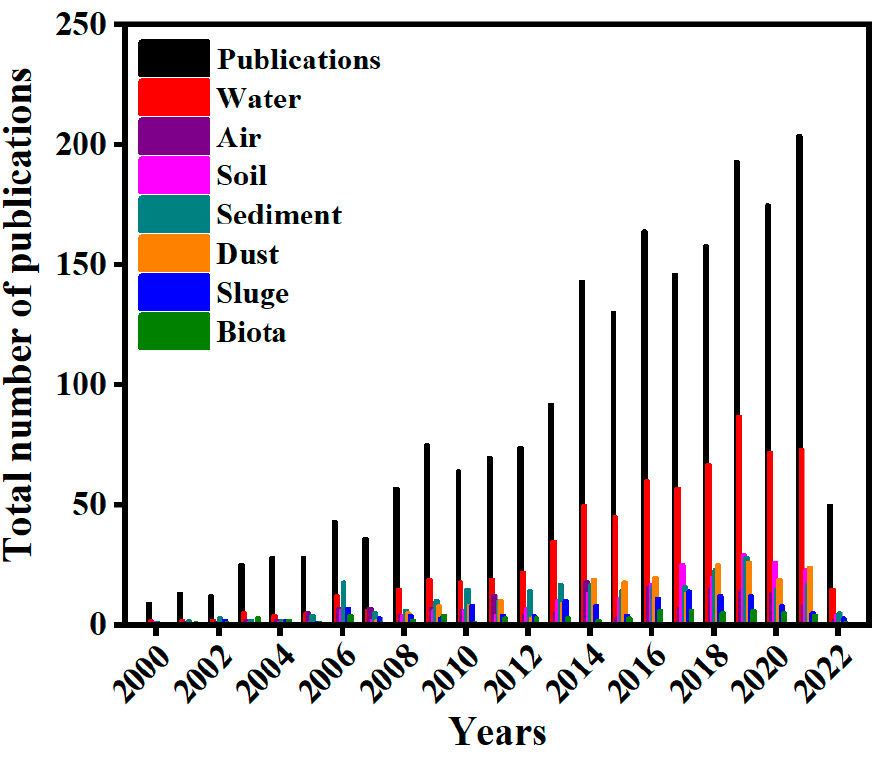
Figure 2. Yearly publications on TBBPA monitoring in environmental samples (Web of Science as of 4–4-2022).